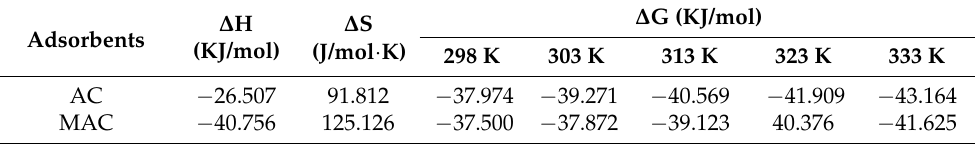
Table 4. Thermodynamic parameters for the adsorption of AZM on AC and MAC.